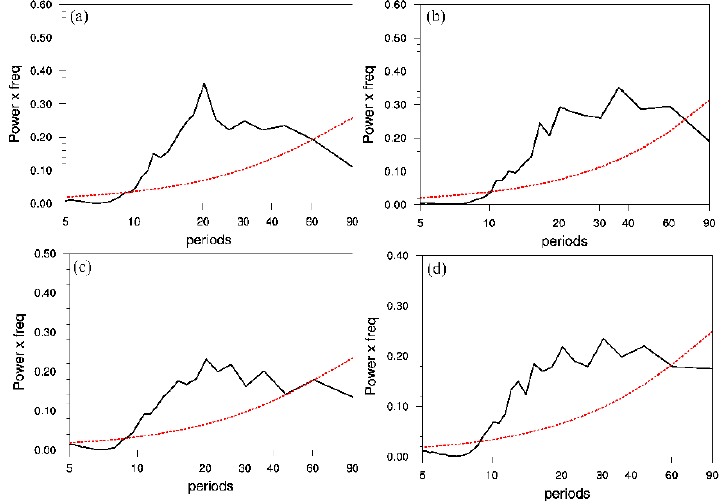
Figure 9. Power spectra of ( a ) SHI, ( b ) UBHI, ( c ) NECVI, and ( d ) EASJI (solid black line). The dashed red line represents the 95% significant level of the red noise spectrum.